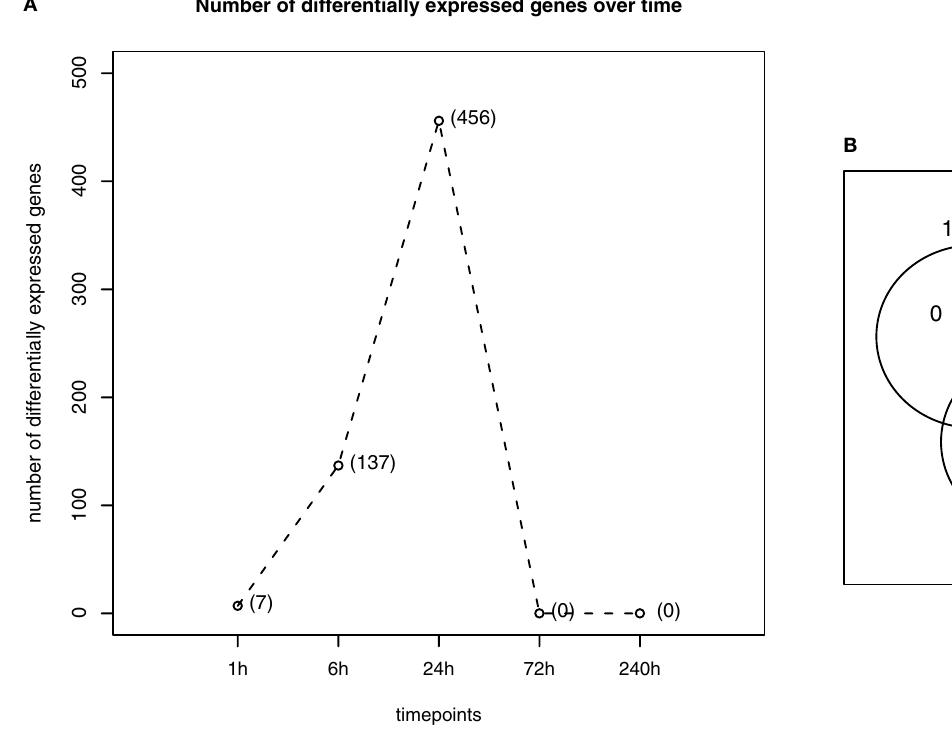
FIGURE 1 | Gene expression over time after KA-treatment for GSE4236 dataset. (A) Changes in the number of differentially expressed genes between different timepoints after treatment. The number in parenthesis represent the